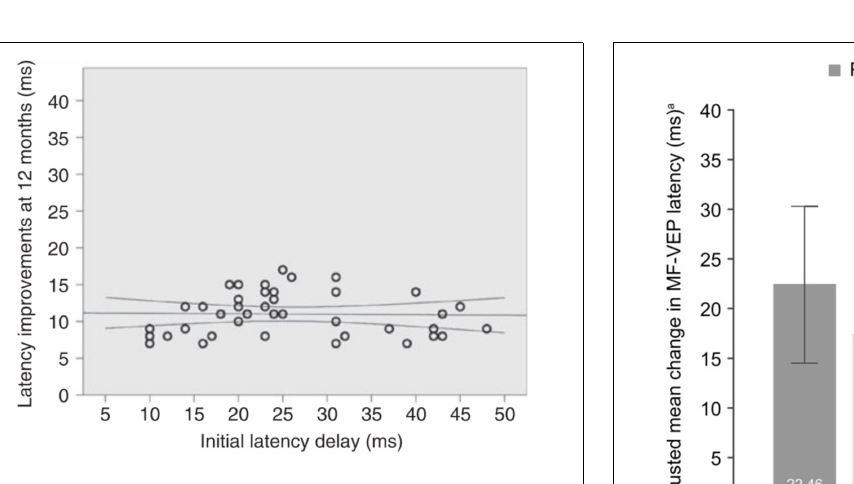
FIGURE 6 | Absolute latency recovery values at 12 months plotted against baseline latency delay [from Klistorner et al. (2010)].